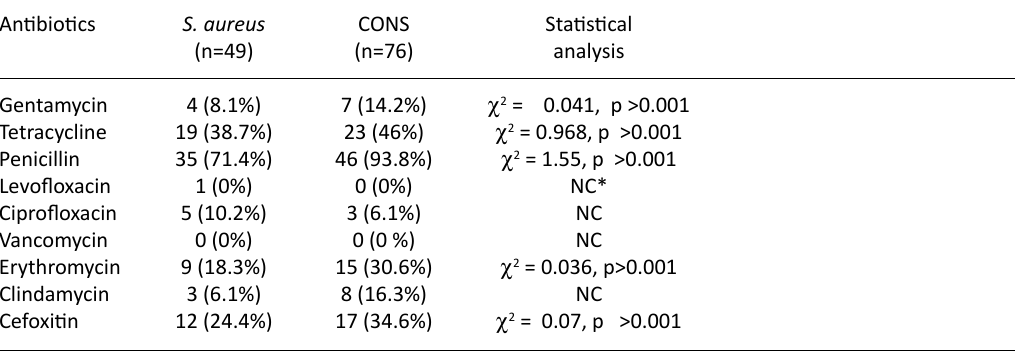
Table 3. Antibiotic resistance pattern of all the Staphylococcus isolates Antibiotics S. aureus CONS Statistical